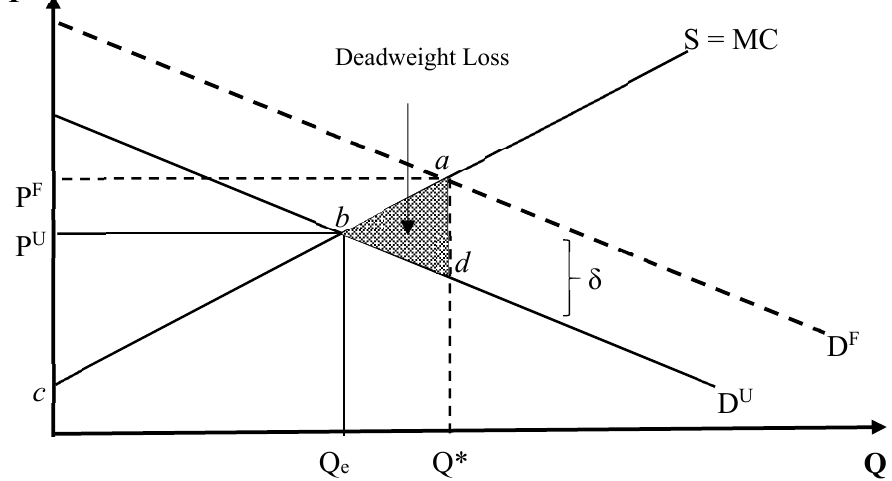
Figure3. Figureshowingthee ff ectofmediocreDi ff erentiatingbetweenInfectedandVaccinatedAnimals (DIVA) tests for Johne’s disease (JD) and bovine tuberculosis (bTB). The symbol “*” distinguishes the equilibrium quantity, Qe, from the new quantity,